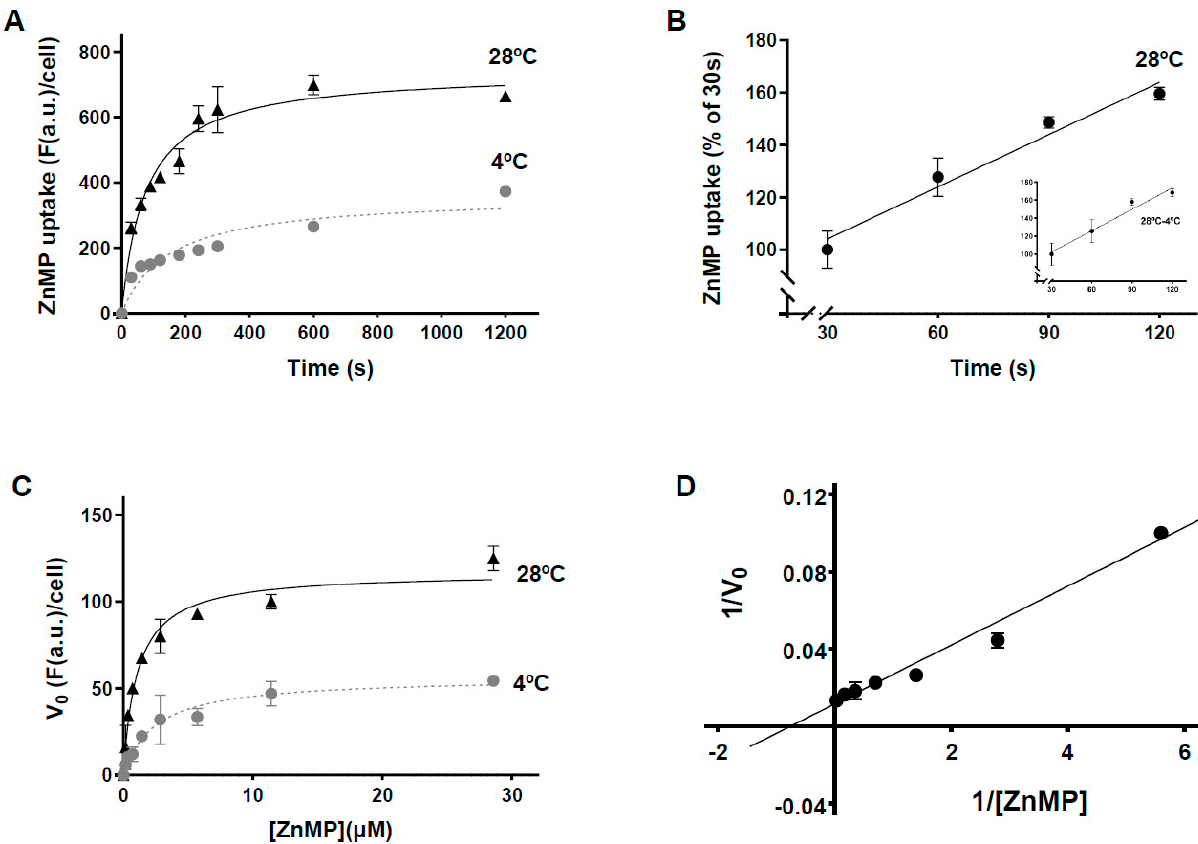
Figure 1. Kinetic characterization of the ZnMP uptake process in L. major promastigotes. ( A ) Tem- perature and time dependence of ZnMP incorporation . The import of 200 µM porphyrin (50 µM ZnMP/150 µM hemin) was measured as described in Materials and Methods at 28 °C (black) or 4 °C (gray) over 20 min. ( B ) ZnMP uptake follows a linear function during the first 120 s. Data obtained in A during the first 120 s at 28 °C were adjusted to a linear function (R 2 = 0.968). The inset shows the net porphyrin incorporation (difference between values obtained at both temperatures) (R 2 = 0.965). ( C ) ZnMP uptake by L. major is substrate saturable . Initial porphyrin uptake (V o ) was measured at the ZnMP concentrations indicated over 120 s at 28 °C (black) or 4 °C (gray) as de- scribed in Materials and Methods. The data obtained were adjusted to a classic Michaelis–Menten hyperbolic function (R 2 = 0.978 and R 2 = 0.977, respectively). ( D ) Lineweaver–Burk representation of the net porphyrin uptake. (R 2 = 0.984). Data are representative of three experiments and values